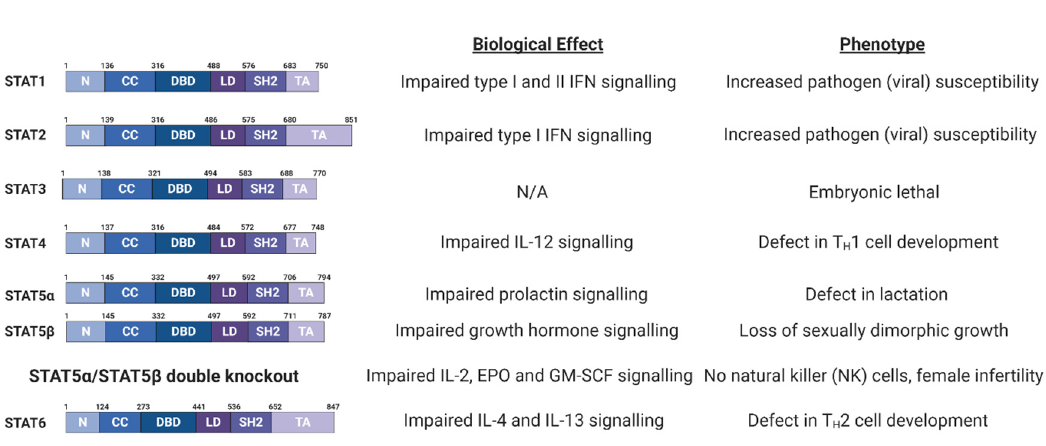
Figure 2. Schematic of Signal Transducer and Activator of Transcription (STAT) protein domain architecture and the biological defects and phenotypes observed in STAT family member knockout (KO) mice. IL, interleukin; IFN, interferon; EPO, erythropoietin; GM-CSF, granulocyte macrophage colony stimulating factor; N, N-terminal domain; CC, coiled coil domain; DBD, DNA-binding domain; LD, linker domain; SH2, Src Homology 2; TA, Transactivation domain [90–97]. Figure created using BioRENDER.com.